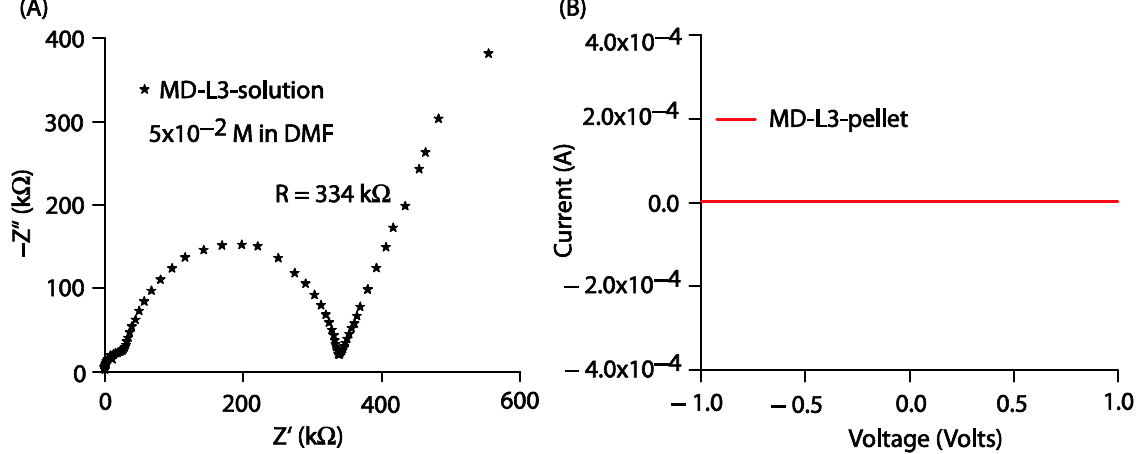
Figure 10. ( A ) Nyquist impedance plot for Comp2 solution in DMF (5 × 10 −2 M), ( B ) I-V characteris- tics for Comp2